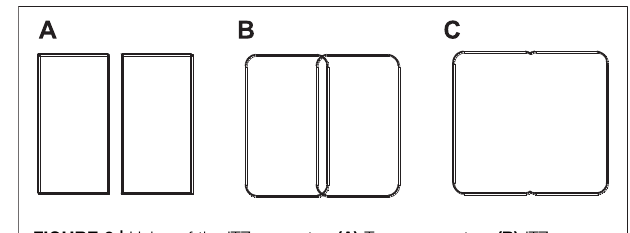
FIGURE 1 | Concrete ITZ generation using the Minkowski sum.